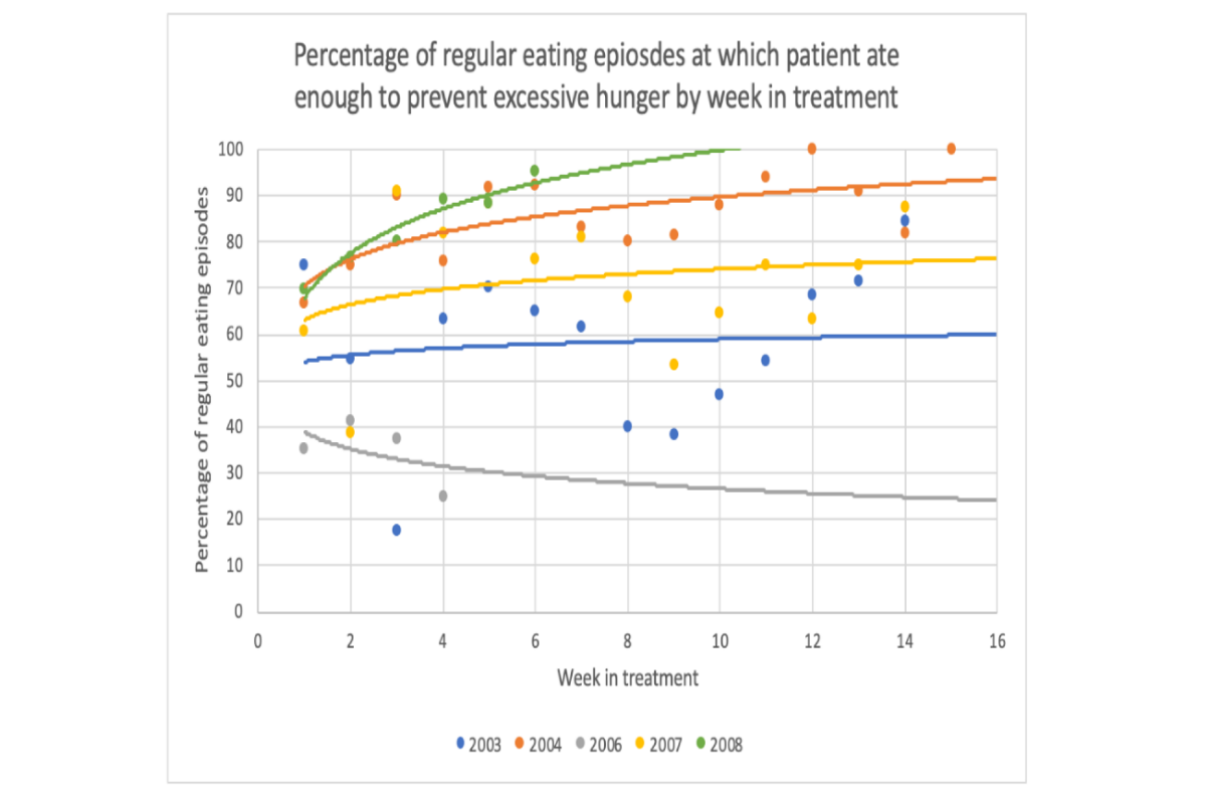
Figure 6. Change in frequency with which patients endorsed eating enough at regular eating episodes throughout treatment.